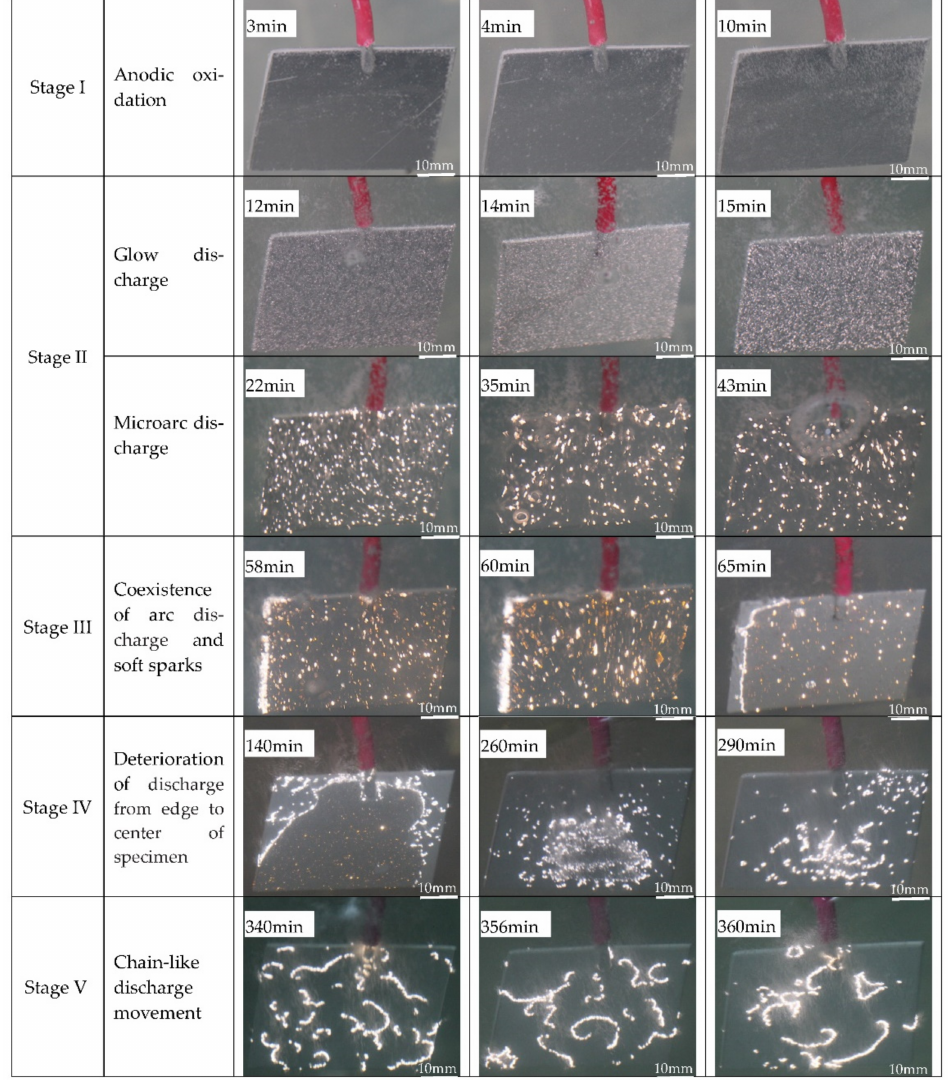
Figure 2. Evolution of microdischarge throughout the entire PEO